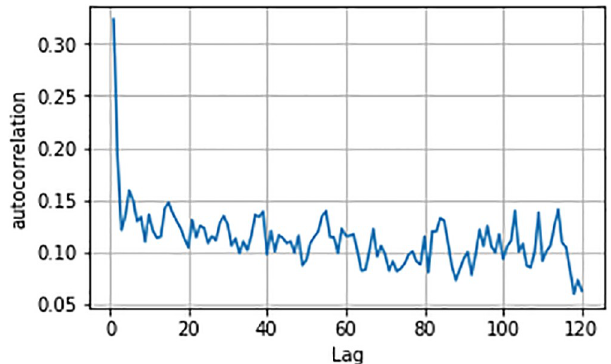
Fig 5. Autocorrelation function estimated from all individuals’ stable